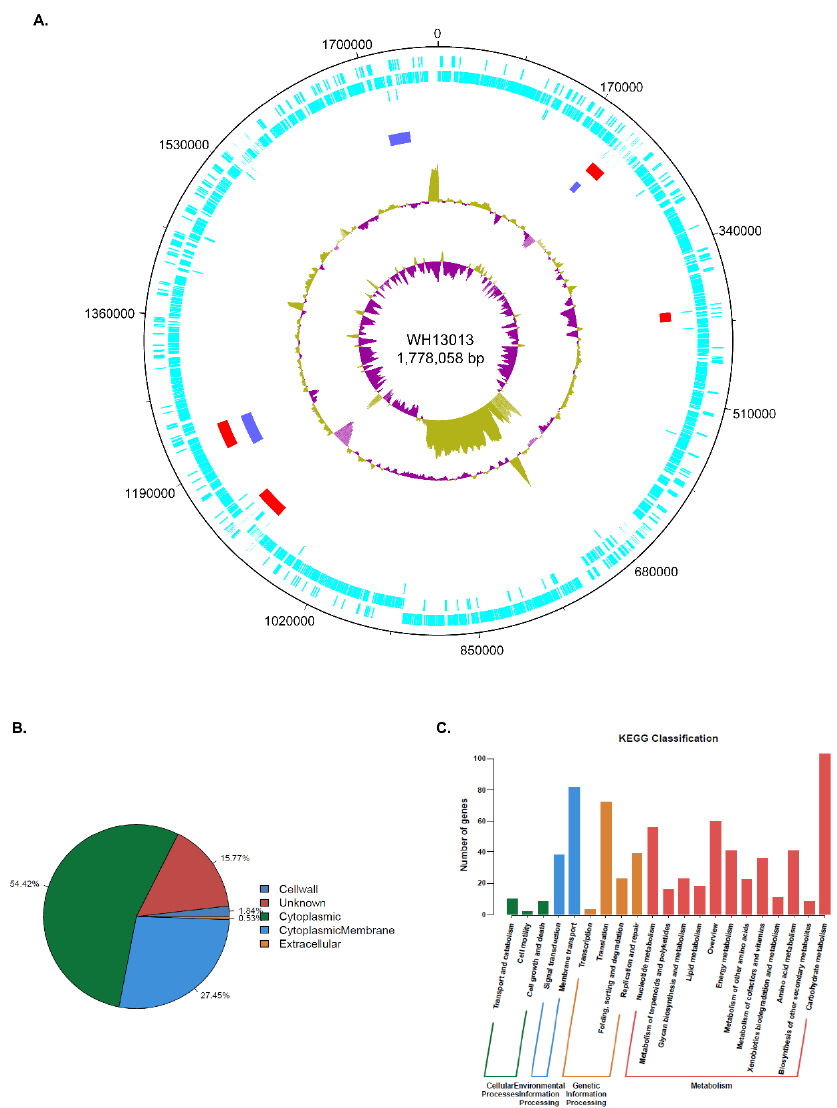
Figure 1. General features of the WH13013 complete genome. ( A ) Circular map of the complete genome of WH13013 which was generated via DNAPlotter. From the outside to the inside, the circle 1 represents the DNA base position (bp); circle 2 (cyan-blue), protein-coding regions transcribed clockwise; circle 3 (cyan-blue), protein-coding regions transcribed anti-clockwise; circle 4 (cyan-blue), predicted RNA genes; circle 5 (red), predicted genomic islands; circle 6 (blue), predicted phages sequences; the two innermost circles represent G + C content and GC skew, respectively. ( B ) Pie chart showing the proportions of the genes encoded by the WH13013 genome localizing in different places of the cells. ( C ) Bar graph showing the number of genes being assigned into different KEGG classifications.